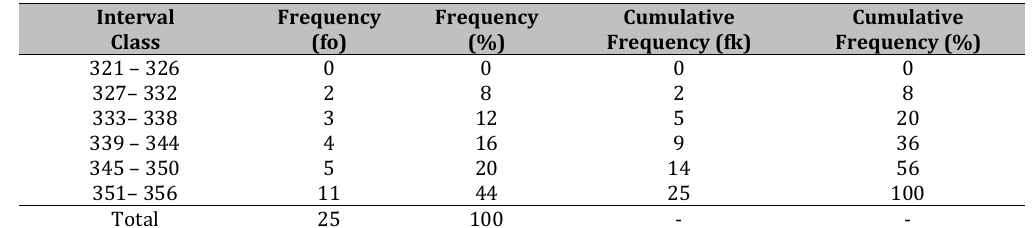
Table 6 Frequency Distribution of Effectiveness of Teachers’ Performance Using Academic Supervision Model Guidebook in